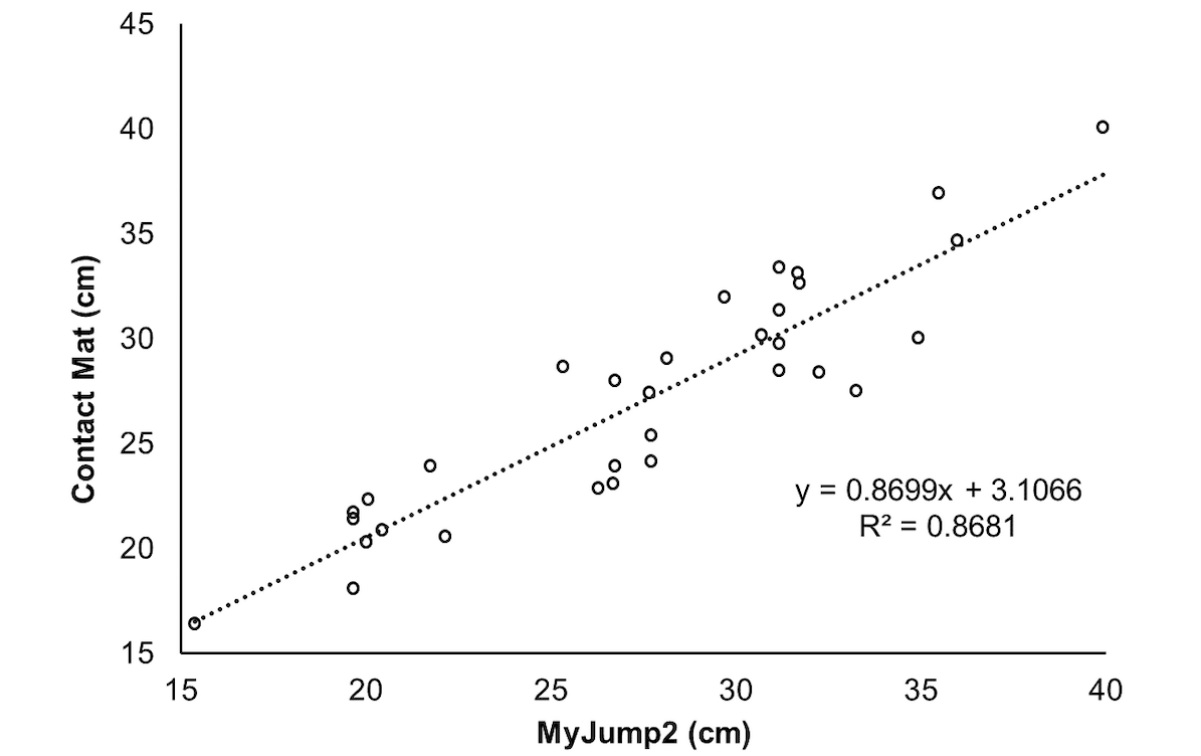
Figure 4. Correlation for agreement analysis of countermovement